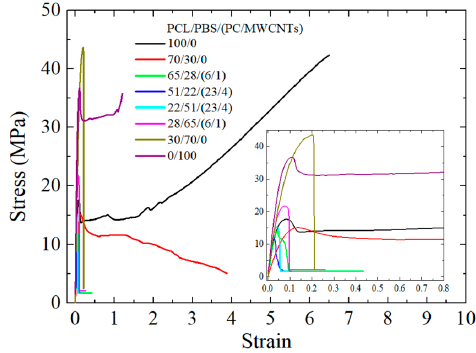
Figure 8. Influence of PC/MWCNTs masterbatch content on the thermal conductivities of the